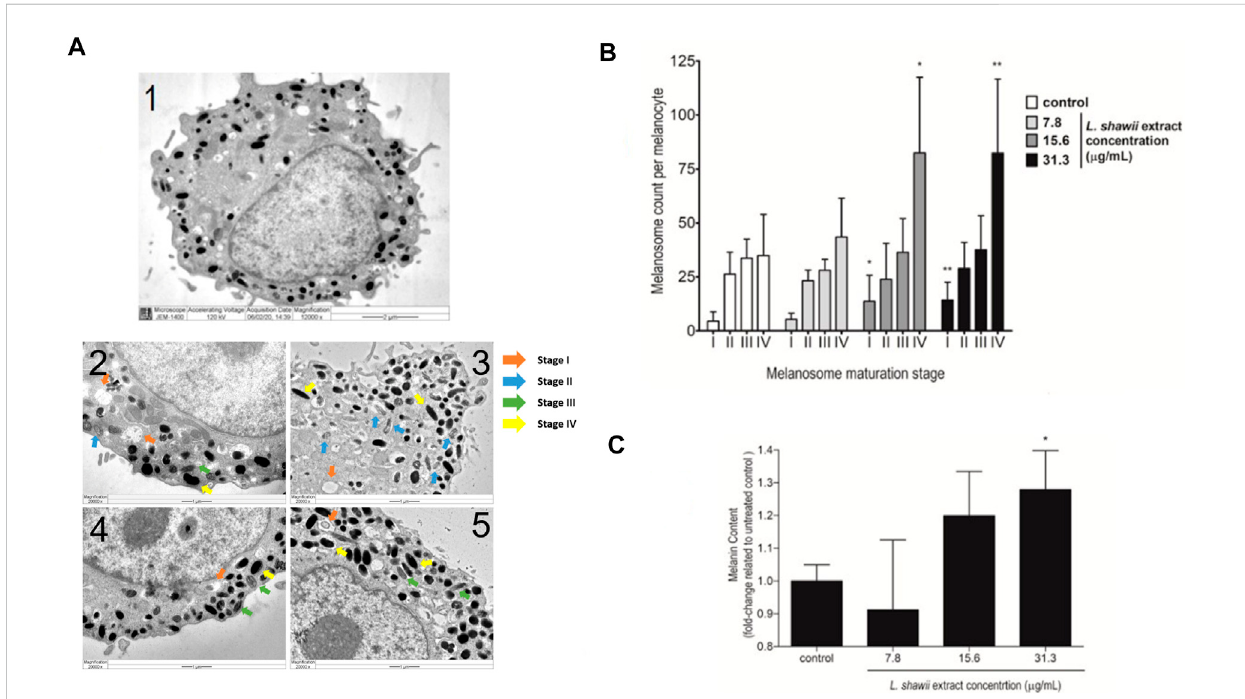
FIGURE 4 Stimulatory effects of the L. shawii extract on melanosome maturation and melanin production in primary human melanocytes. (A) Representative electronmicroscopicphotomicrographsofamature(1)humanmelanocyteshowingvarious(I – IV)stagesofmelanosomesintheabsence(2)orpresence of 7.8 μ g/mL (3), 15.6 μ g/mL (4), and 31.3 μ g/mL (5) of the L. shawii extract. The arrows indicate examples of melanosome stages as follows: stage I showing a planar clathrin coat, intraluminal vesicles, and membranous tubules; stage II characterized by intraluminal amyloid sheets; stage III showingelectron-densemelanindeposits;stageIVcharacterizedbythe fi llingofthemelanosomelumenwithelectron-densemelanin(Benito-Martínez et al., 2020). (B) The bar graph indicates the effects of the L. shawii extract on melanosome formation at different stages of maturation per ten separate melanocytes per each L. shawii -treated and untreated cells. (C) The bar graph shows the measurement of melanin content after treatment with the L. shawii methanolic extract. The results are presented as the mean ± SD of three independent experiments. * p < 0.05 and ** p < 0.01 signify a statistically signi fi cant difference compared with the